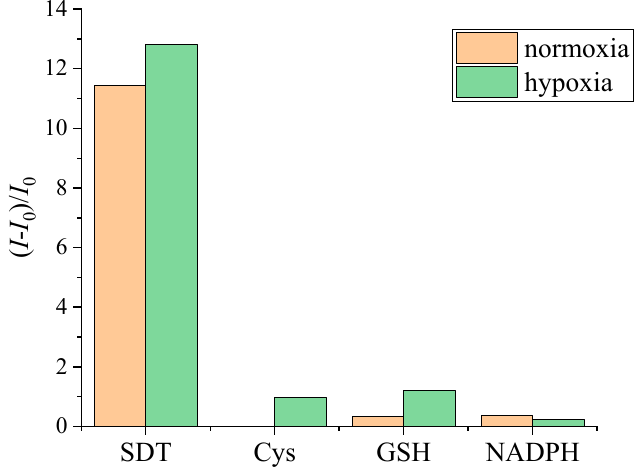
Figure 7. Fluorescent responses of Rh6G - L (30/10 µ M) at 545 nm ( λ ex = 490 nm) to various re- ductants. The complex was treated with either SDT or various biological reductants (Cys: Cysteine, GSH: glutathione, NADPH: reduced nicotinamide adenine dinucleotide phosphate) under normoxic or hypoxic conditions. Incubation time is 25 min. C ( Rh6G ) = 10 µ M, C ( L ) = 30 µ M, C (reductants) = 100 µ M, PBS buffer (pH 7.4) at 37 °C.